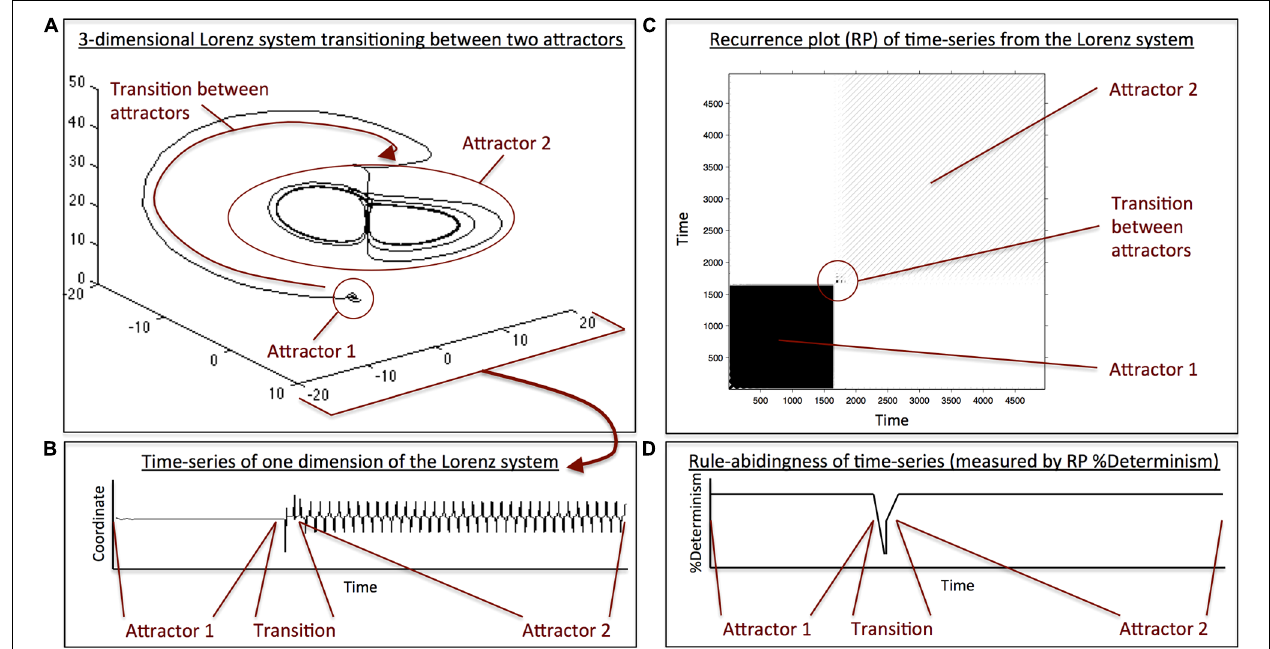
degree of temporal structure in the behavior of the time-series. White areas represent the absence of temporal structure in the time-series. The RP is similar to an autocorrelation plot, where time at lag0 runs along the diagonal. As one moves away from the diagonal toward the upper-left or lower-right part of the plot, one sees time-lagged behavior. Hence, the plot shows that the initial behavior (i.e., behavior in attractor 1) is highly structured, indicated by the dark area in the lower-left. Similarly, behavior in attractor 2 is highly structured, indicated by the striped area in the upper-right. However, the transition period between the two attractors is marked by a brief absence of structure. (D) Illustration of an RP-based measure of structuredness (%Determinism) of the time-series in (B) . For both attractors, 1 and 2, the time-series possesses a high degree of temporal structure, but the transition between both attractors is marked by a loss of structure, indicated by the dip in %Determinism.